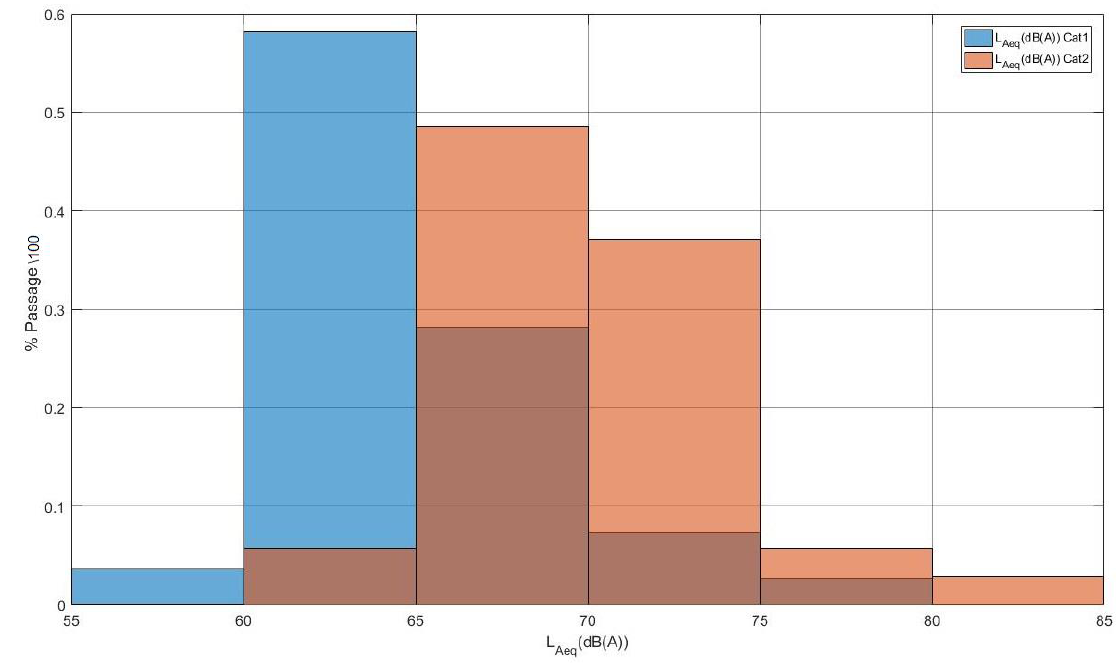
Figure 2. Histogram of noise produced by two categories of small vessel pass-by events at a 7.5 m distance.